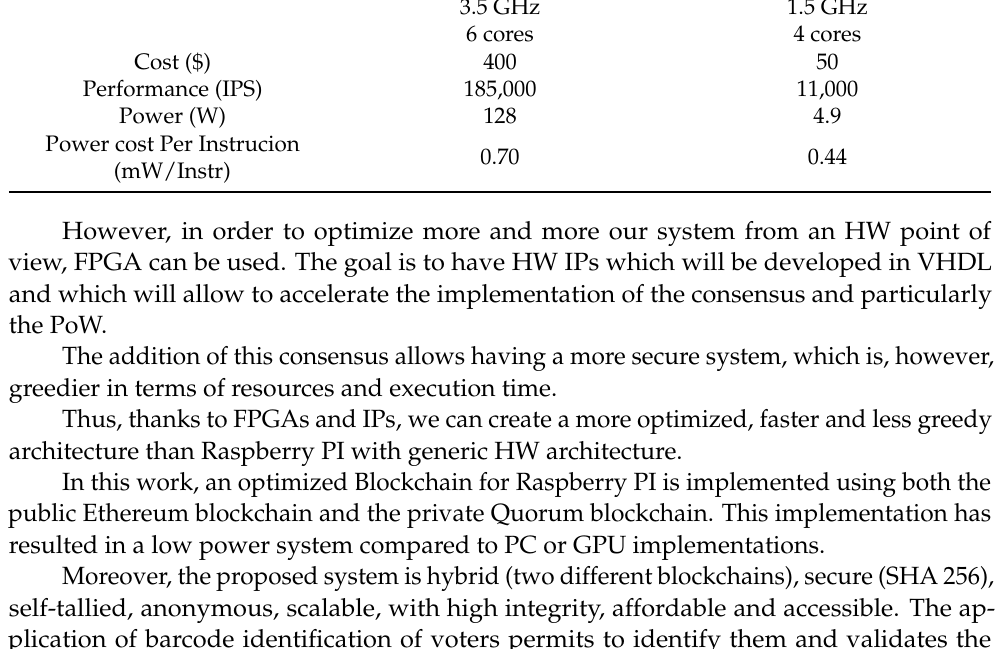
Table 2. Compared performance/consumption. Xeon Raspberry Pi Characteristics X86-64 ARM 7-8 3.5 GHz 1.5 GHz 6 cores 4 cores Cost ($) 400 50 Performance (IPS) 185,000 11,000 Power (W) 128 4.9 Power cost Per Instrucion 0.70 (mW/Instr)